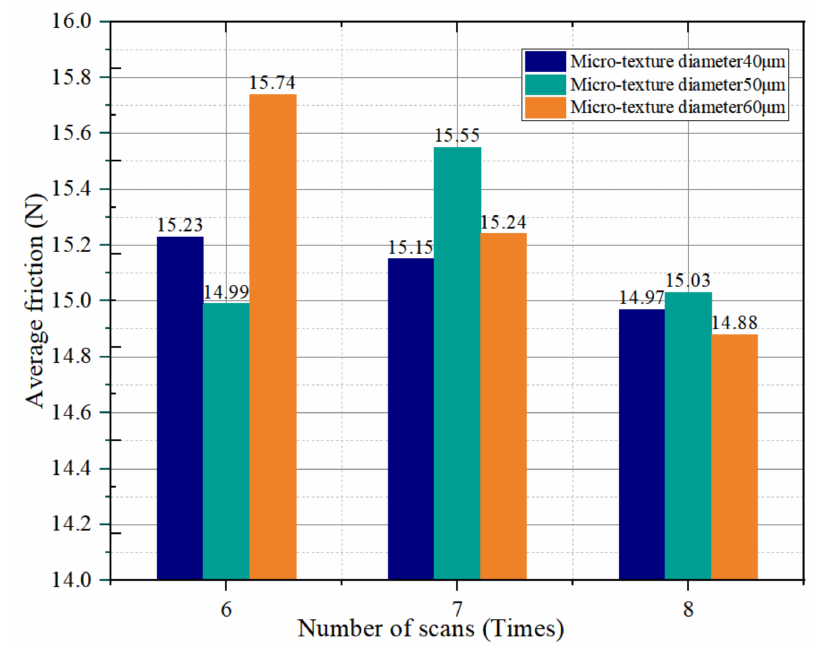
Figure 11. Binary diagram for the